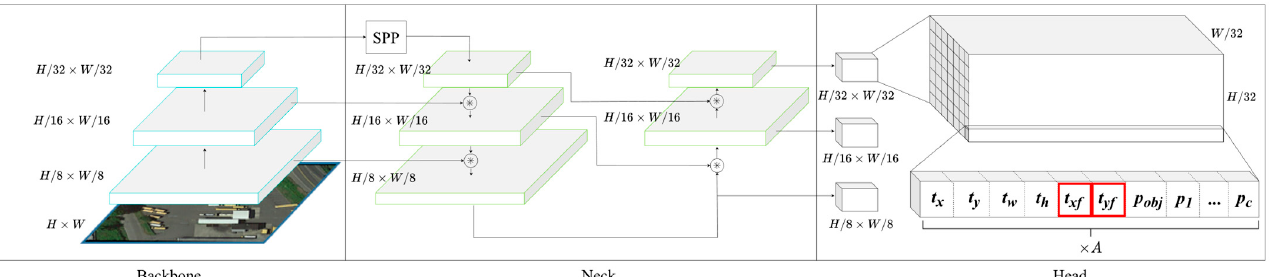
Figure 3. The network architecture of our proposed method. The feature extraction (backbone) and feature fusion (neck) parts are kept the same as YOLOv4. Meanwhile, two additional channels t xf and t yf are added into the grid cells (head) at different scale levels. Thus, each grid cell contains an (C + 7) A dimensional vector, where C is the number of classes, A is the number of predefined anchors in each prediction layer and each anchor contains seven parameters: t x , t y , t xf , t yf , t w , t h and confidence p obj . (cid:126) denotes feature map